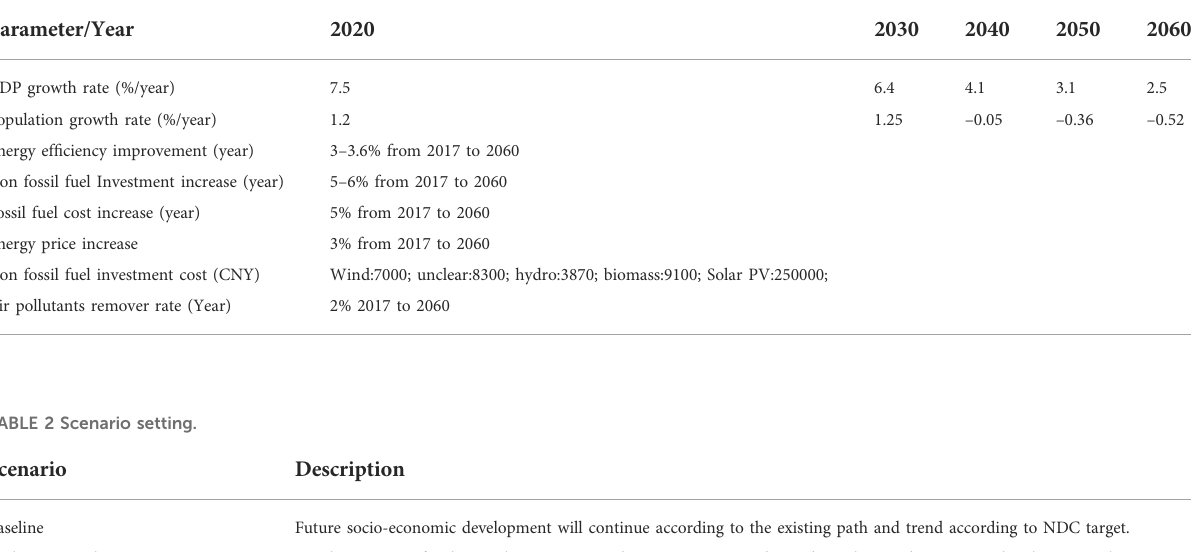
TABLE 1 Parameters setting in IMED|CGE model.